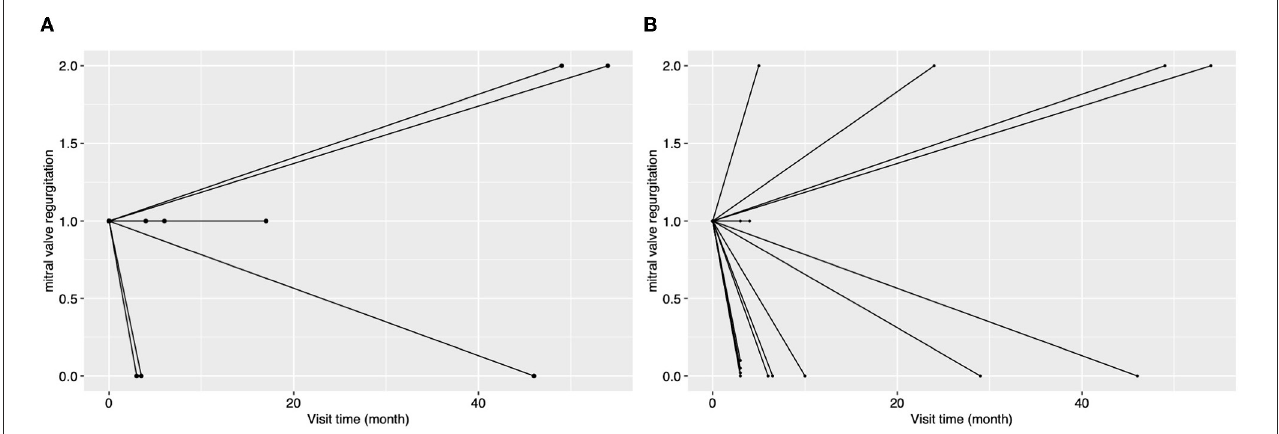
FIGURE5 The changes in the degree of MR for patients with rheumatic aortic valve disease [ (A) , n = 8] or with atrial fibrillation [ (B) , n = 15] during the follow-up. In this figure, every line indicates the changes in the degree of mitral regurgitation for a single patient, and the two ends of a line indicate the preoperative echocardiography assessment and the last follow-up echocardiography